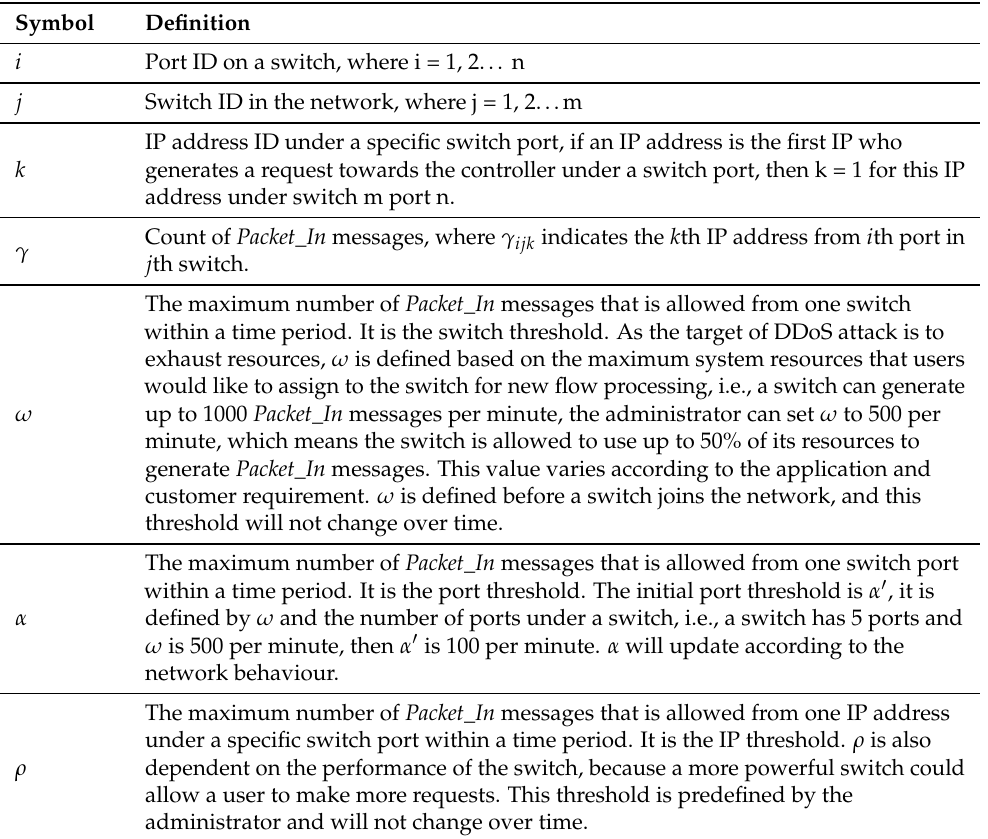
Figure 2. Workflow of SECOD algorithm. Table 4. Parameters in the SECOD